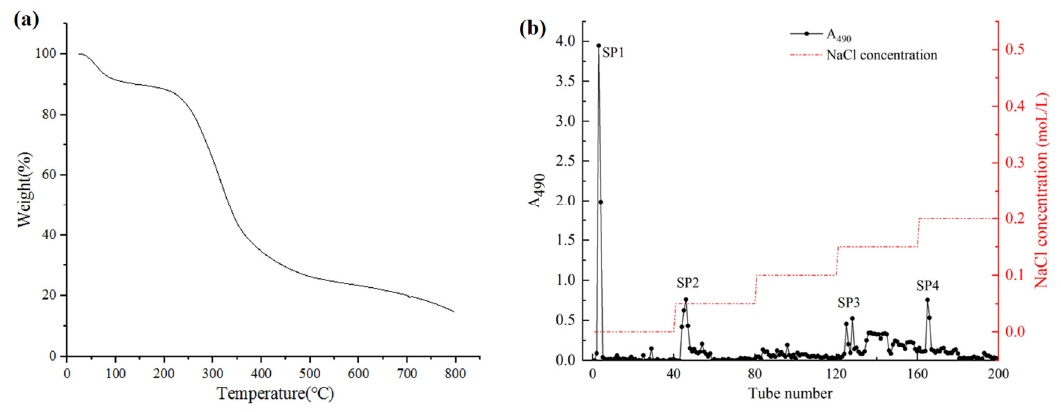
Figure 1. The TGA thermogram ( a ) and elution curve ( b ) of CSP.